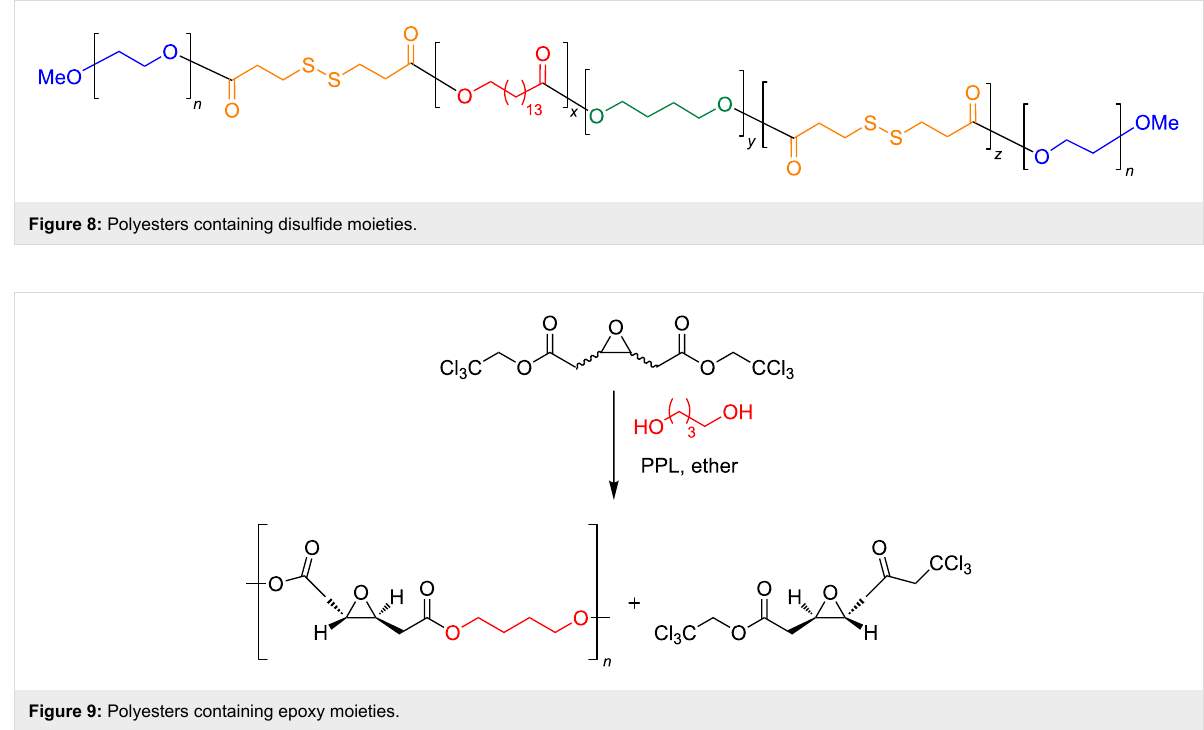
Figure 9: Polyesters containing epoxy